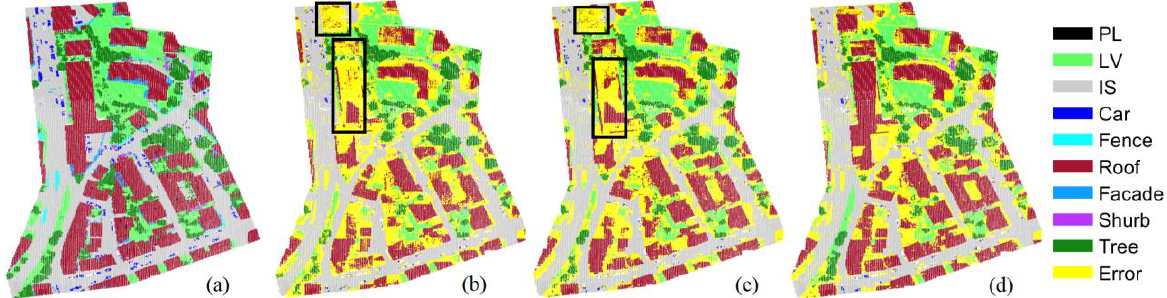
Figure 5. classification results for the Vaihingen test data set (Scene 1). (a) ground-truth, results of: (b) simple random sampling based train/test split, (c) stratified sampling based train/test split, and (d) stratified sampling based R k -CV. Many points are misclassified in the black rectangles for plots b and